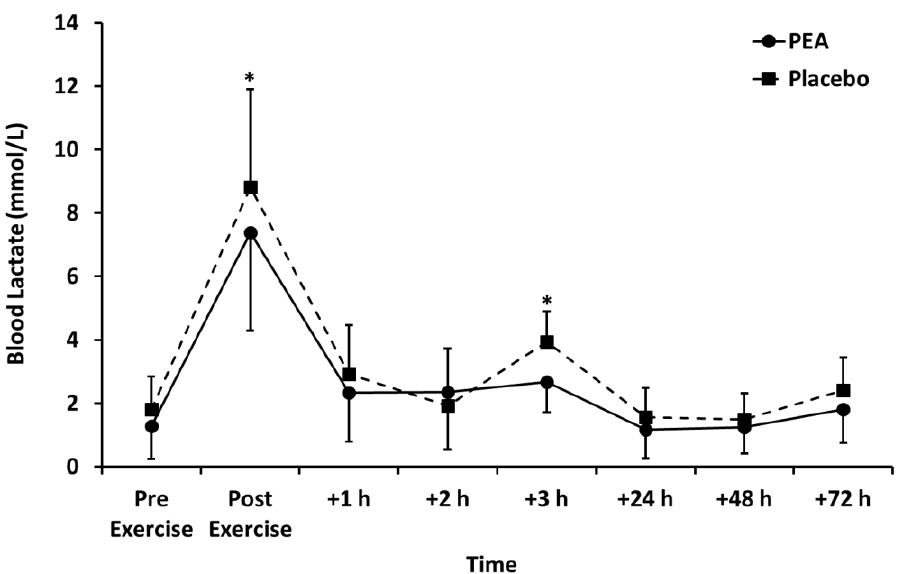
Figure 4. Blood lactate concentration for palmitoylethanolamide (PEA) and placebo groups. Values are mean ± SD. * p < 0.05 between groups.